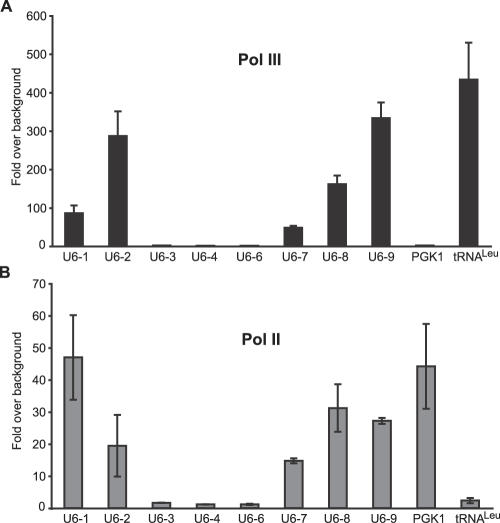
Both Pol II and Pol III Accumulate at Active U6 snRNA Gene PromotersSheared chromatin from pemHeLa cells that had been crosslinked with formaldehyde was immunoprecipitated with (A) anti-Pol III (1900) or (B) anti-Pol II antibodies (8WG16). DNA was purified following reversal of crosslinks. qPCR primers specific for regions ∼ 300 bp upstream of active and inactive U6 genes (U6–1, U6–2, U6–7, U6–8, U6–9 and U6–3, U6–4, U6–6, respectively), PGK1, and tRNALeu genes (Pol II and Pol III controls, respectively). All values are relative to nonimmune IgG and normalized to an intergenic control region. Error bars represent the SEM of at least three independent experiments.